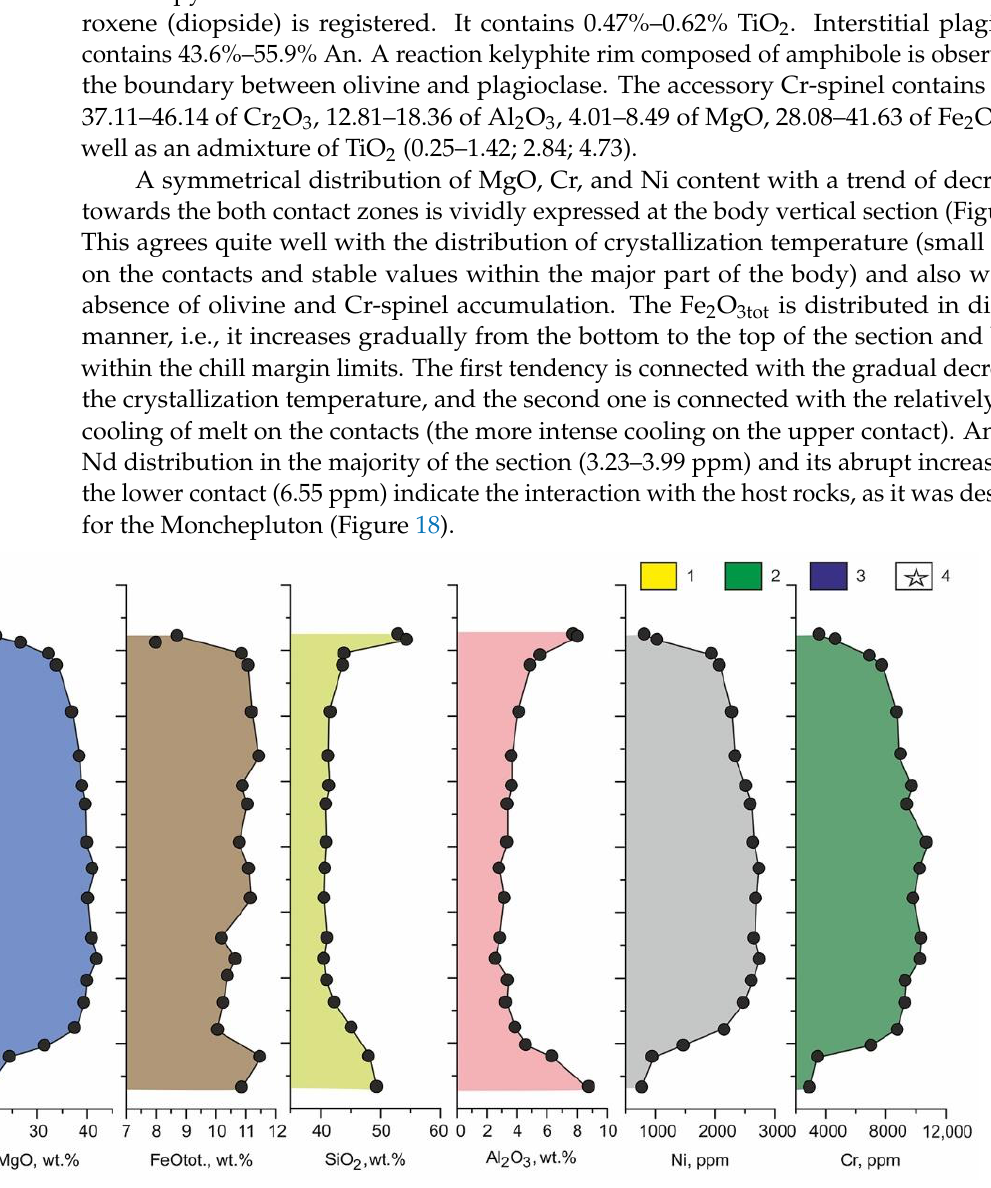
Figure 19. Variations in MgO, FeOtot, Ni, and Cr content according to the vertical cross-section of the intrusive body (M-1 borehole, 2037–2383 m). 1: Host rocks of the Archean Complex; 2: Chill margin rocks; 3: Plagioharzburgites; 4: M-75 sample location.